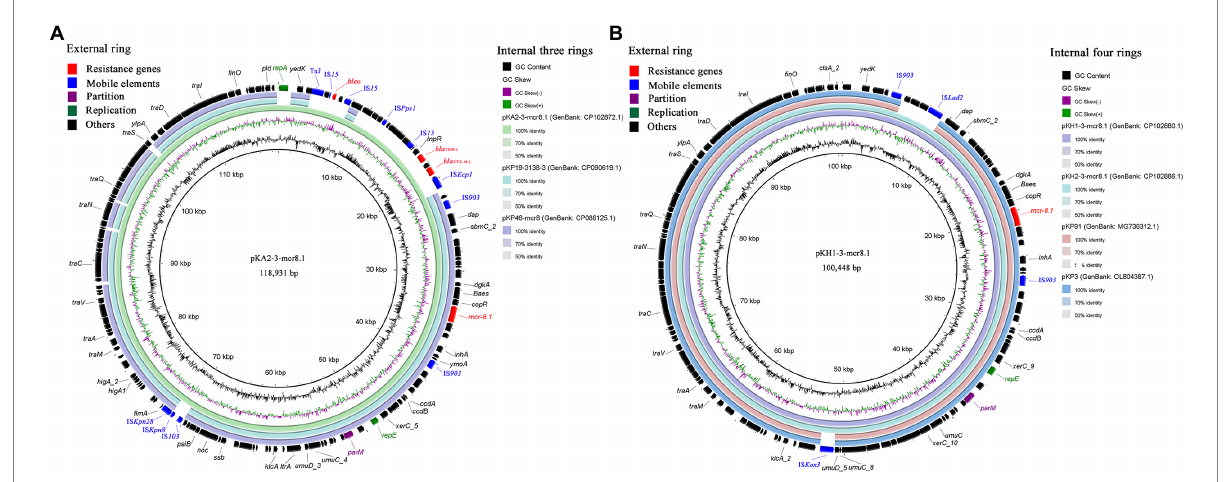
FIGURE 3 The blast and annotation of mcr-8.1 -carrying plasmid genomes (constructed by BRIG). Genes are color-coded depending on functional annotations. (A) The three internal rings represent plasmids pKA2-3-mcr8.1, pKP19-3,138-3 (GenBank: CP090619.1) and pKP46-mcr8 (GenBank: CP088125.1). The external ring represents the annotation of plasmid pKA2-3-mcr8.1. (B) The four internal rings represent different mcr-8.1 - carrying plasmids from this study and GenBank database. The external ring represents the annotation of plasmid